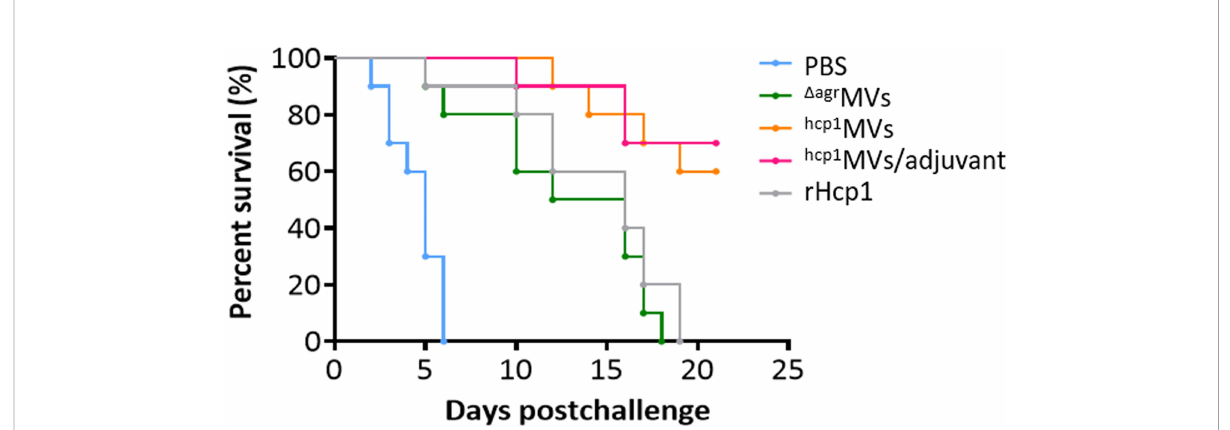
FIGURE 4 Hcp1-loaded MV vaccination protects mice from acute melioidosis. BALB/c mice ( n = 10 per group) were vaccinated with PBS, D agr MVs, hcp1 MVs, hcp1 MVs/adjuvant, or rHcp1 by a three-dose regimen at 10-day intervals. Then, mice were infected with 5 × LD50 of B. pseudomallei BPC006